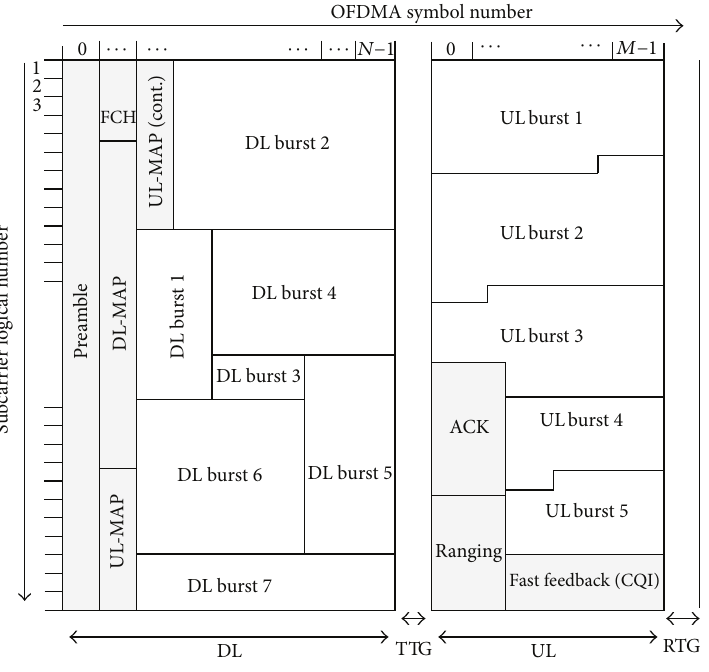
Figure 2: Frame structure of IEEE 802.16e-TDD.